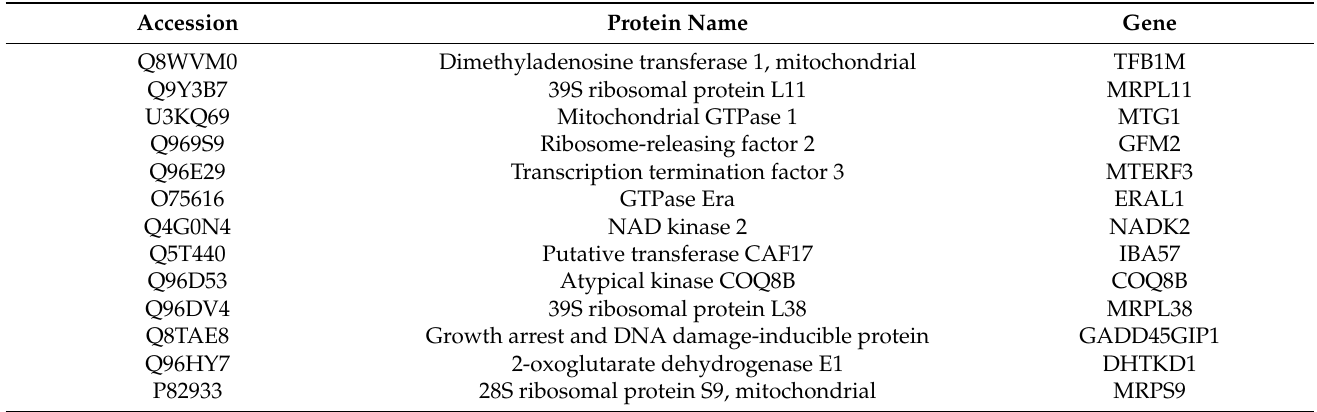
Table 1. Proteins with well-defined mitochondrial localization after VX-809 treatment, but not classified as mitochondrial in the